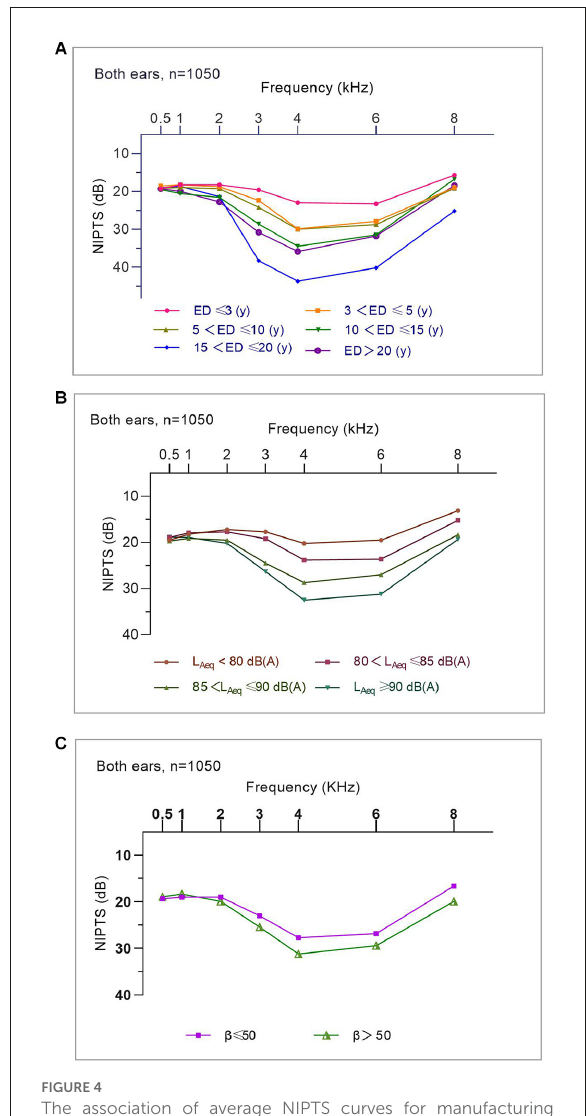
FIGURE4 The association of average NIPTS curves for manufacturing workers with noise exposure duration, noise intensity, and kurtosis levels. (A) Average NIPTS curves of workers with different noise exposure duration. (B) Average NIPTS curves of workers exposed to noise at different L Aeq.8h levels. (C) Average NIPTS curves of workers exposed to noise at different kurtosis